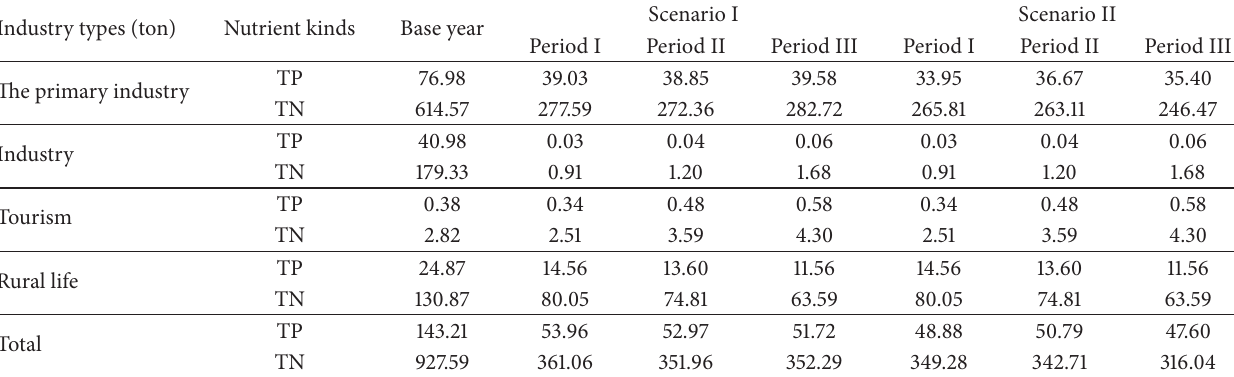
Table 6: TP and TN loads distribution of representative